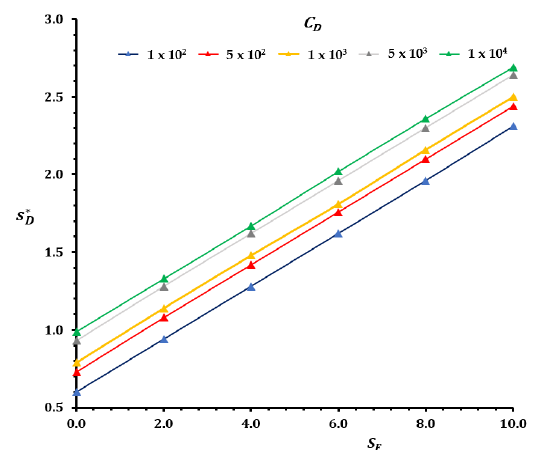
Figure 7. Dependence s D * vs. skin factor, S F , for values of C D (1 × 10 2 , 5 × 10 2 , 1 × 10 3 , 5 × 10 3 , and 1 × 10 4 ) and S F (0, 2, 4, 6, 8, and 10).